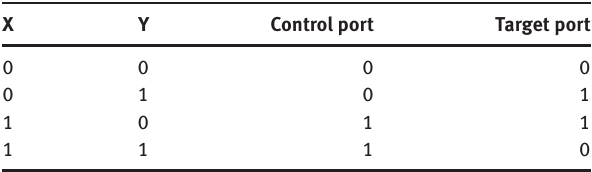
Table 1: The truth table achieved by the proposed